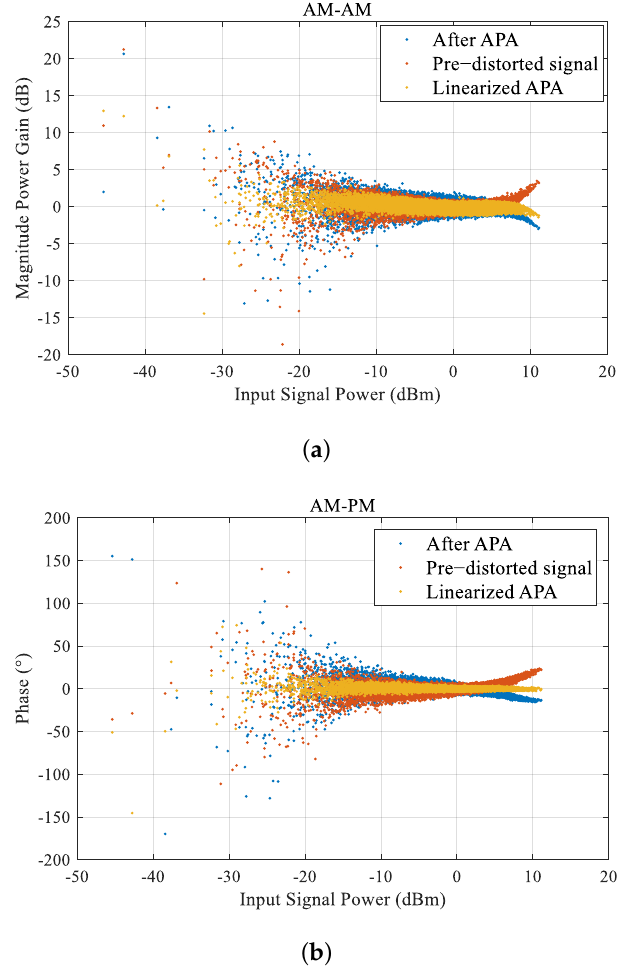
Figure 12. Measured AM-AM and AM-PM curves with the proposed technique for 100 MHz OFDM signal: ( a ) AM-AM; ( b ) AM-PM.